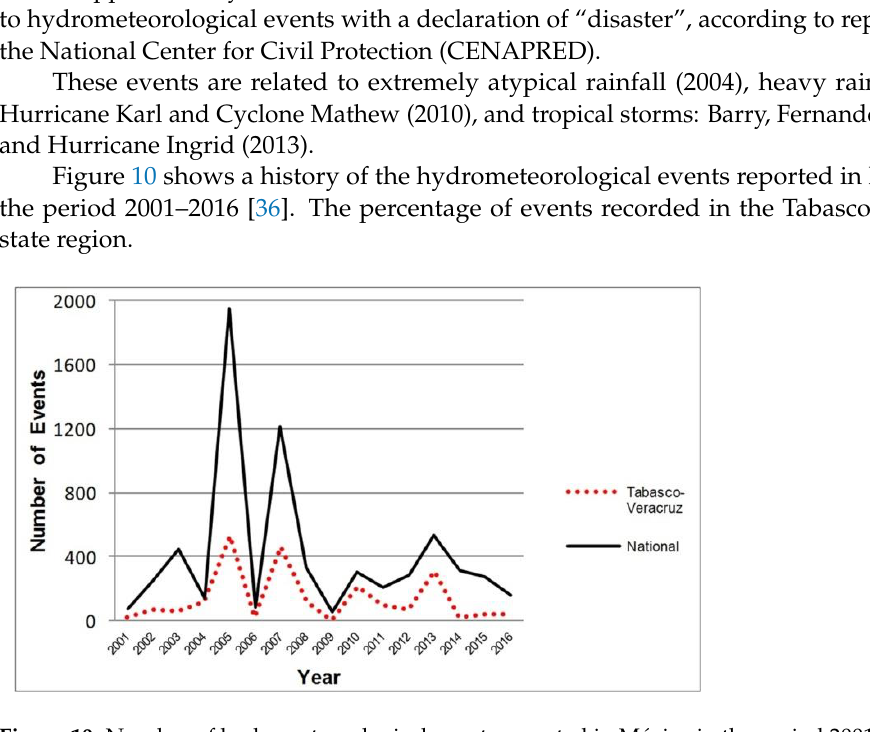
Figure 11. Impact of input variables in crop vulnerability